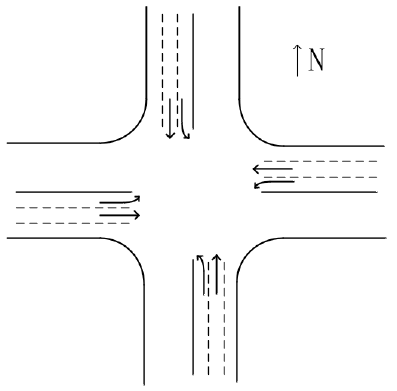
Figure 2. A crossroad.